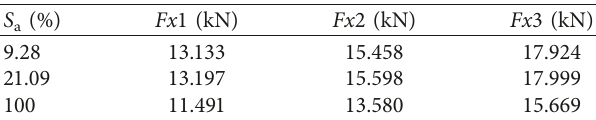
Figure 9: Longitudinal force on the tire at different slip ratios during acceleration. Table 6: Longitudinal force on the tire at some typical slip ratios during